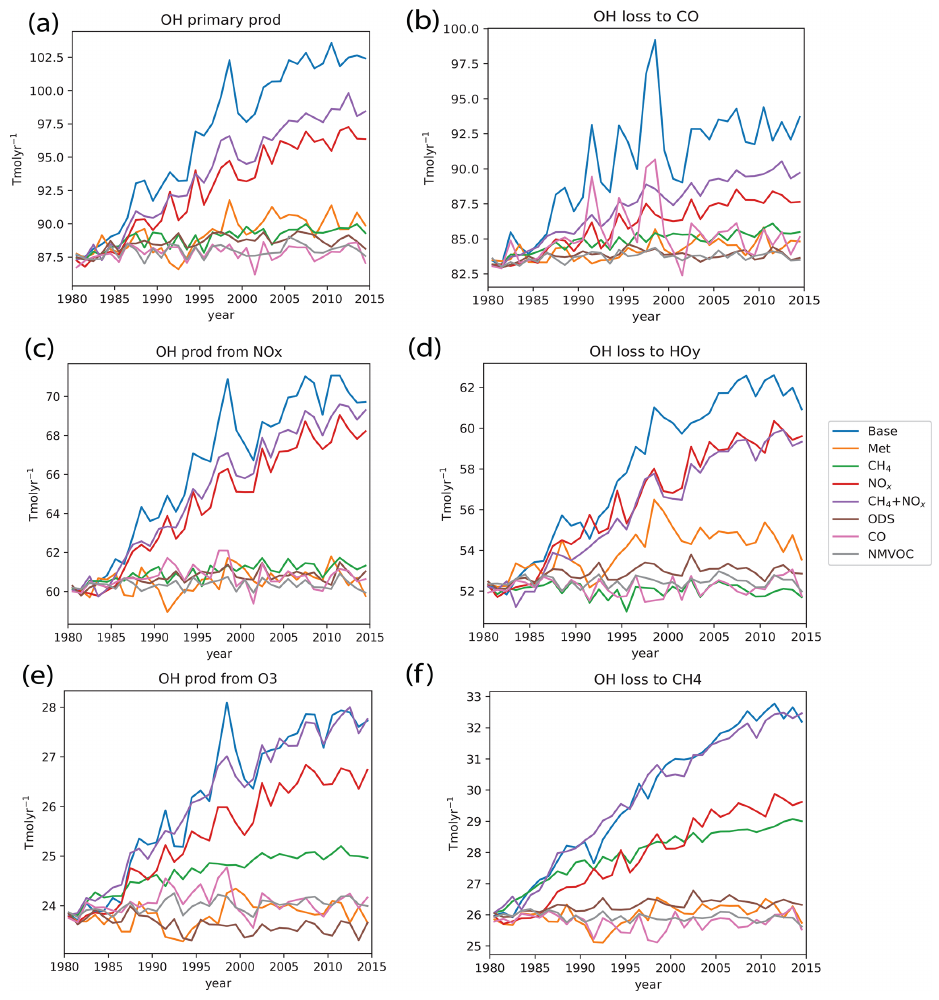
Figure 7. OH chemical production and loss budget terms for the different model runs. Panels (a) , (c) and (e) show the production terms, accounting for ∼ 84% of total OH production. Panels (b) , (d) and (f) show the loss terms and account for ∼ 78% of total OH loss. Globally, increasing NO x emissions have led to increasing primary and secondary OH production, while increasing CH 4 concentrations have led to increased OH loss via reaction with CH 4 that is offset by increased secondary OH production due to the increase in tropospheric O 3